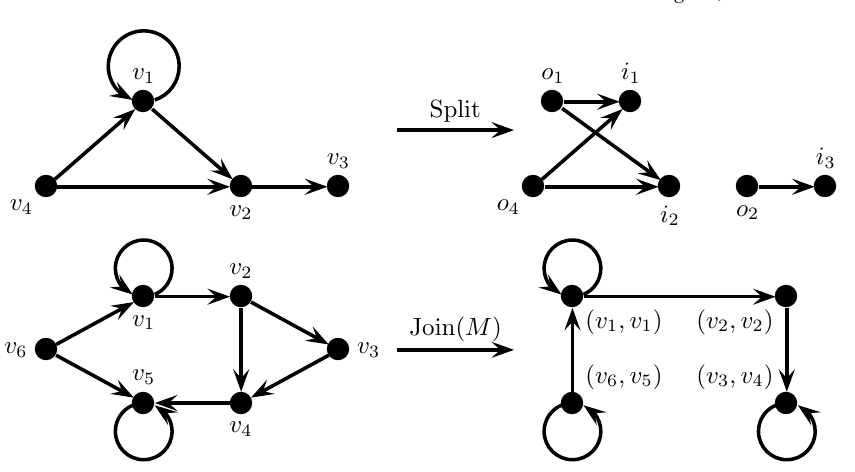
Fig. 1: Examples of the operations Split( D ) and Join( G, M ) for M = { v 1 → v 1 , v 3 → v 4 , v 6 → v 5 } . For the sake of exposition, we write i x and o x to denote the vertices in( v x ) and out( v x ) of Split( D ) , respectively. Note that out( v ) → in( v ) is an arc of Split( D ) if only if v is reflexive, while ( v, w ) is reflexive in Join( G, M ) if and only if either v → w ∈ M or v = w is reflexive in G